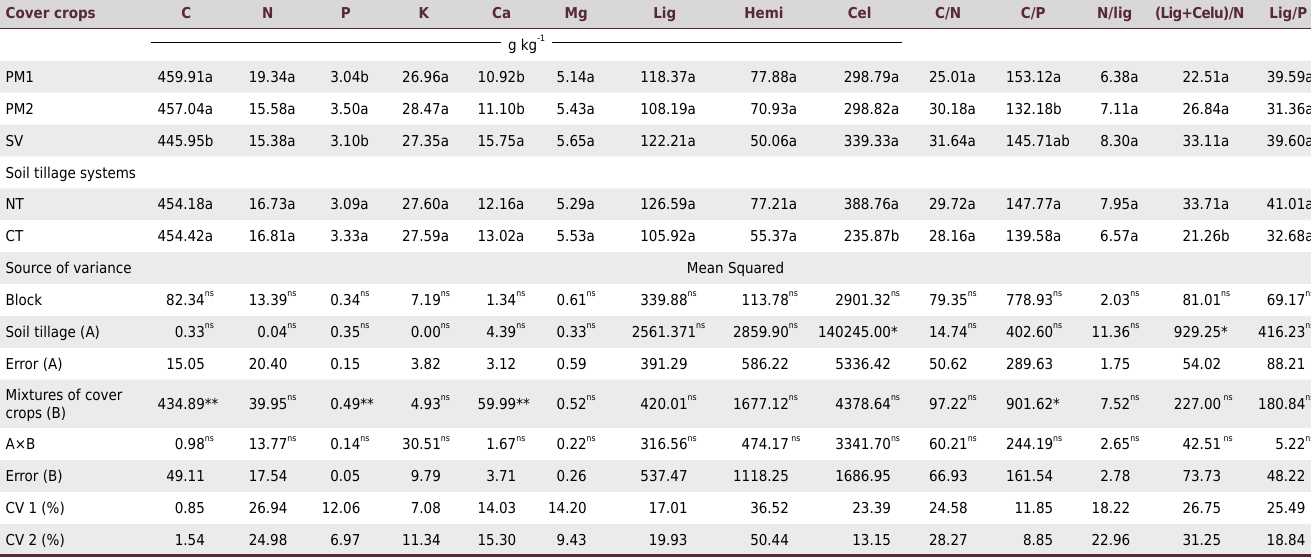
Table 4. Means and mean squared of the chemical properties aboveground phytomass of different mixtures of cover crops cultivated in interrows of a mango agroecosystem in Petrolina, Pernambuco State Cover